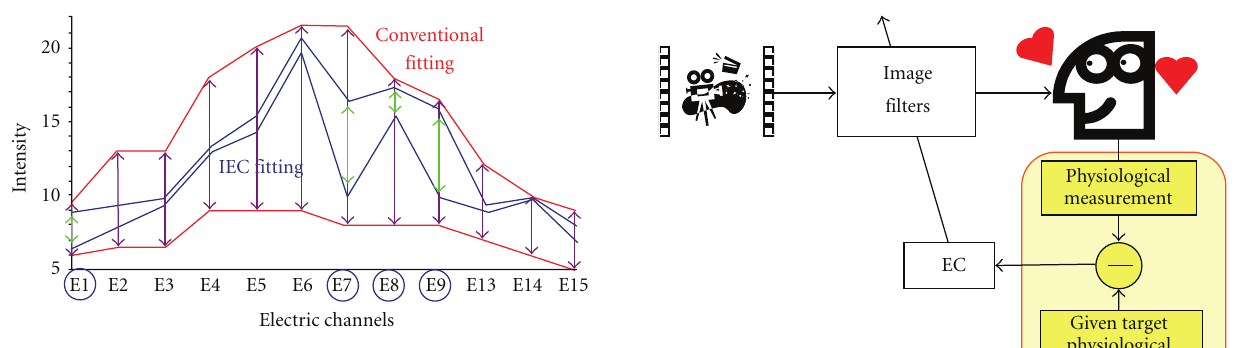
Figure 6: Cochlear implants fitting characteristics: those by conventional manual fitting (dot lines) and those by IEC fitting (solid lines). This figure was made based on Figure 5 in [7]. Figure 7: Example application of extended IEC for explaining its